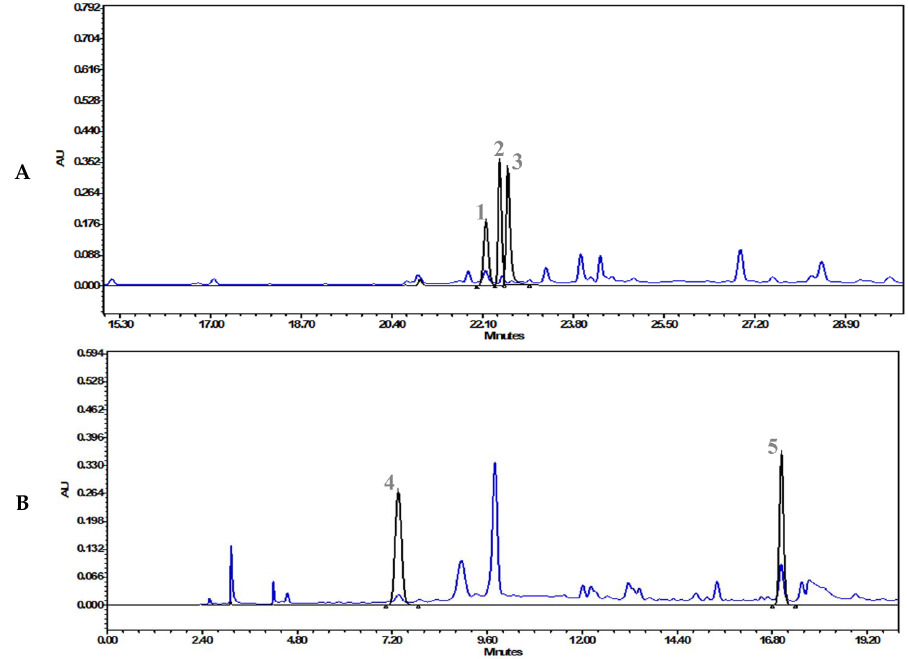
Figure 3. Overlap chromatographs of ( A ) the standard mix of ferulic acid (1, 22.16 min), palmatine (2, 22.42 min) berberine (3, 22.57 min), and T. cordifolia (Giloy)–methanolic extract at 346 nm, and ( B ) the standard mix of gallic acid (4, 7.35 min), vanillic acid (5, 17.03 min), and T. cordifolia (Giloy)–methanolic extract at 270